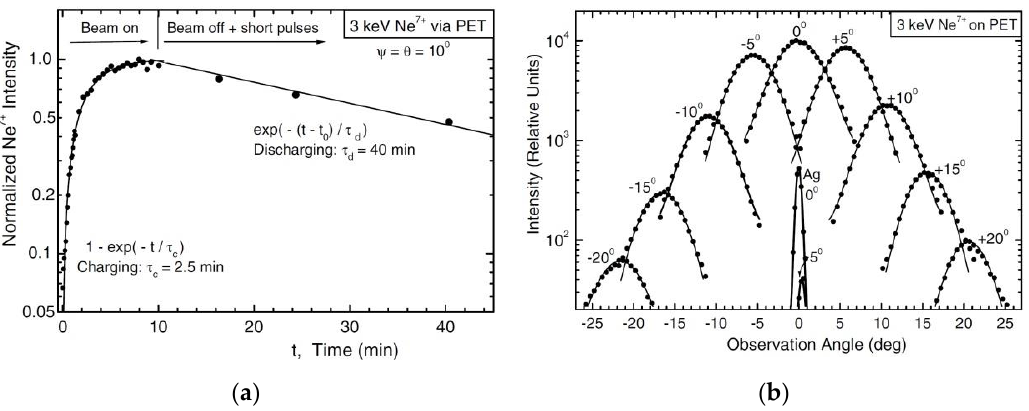
Figure 4. ( a ) Time evolution of normalized transmission intensity of 3 keV Ne 7+ ions through PET capillaries (reprinted figure with permission from [2] Copyright 2002 by the American Physical Society); ( b ) the transmitted beam profiles according to the tilting angles (reprinted figure with permission from [2] Copyright 2002 by the American Physical Society).